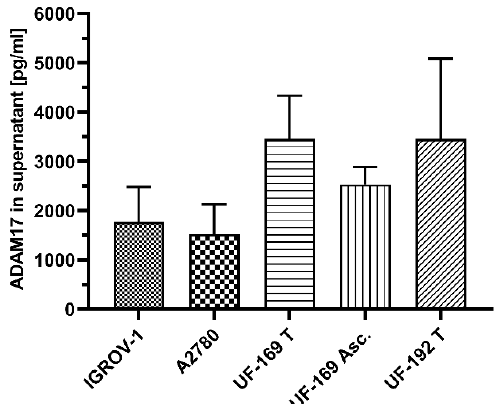
Figure 1. Detection of ADAM17 in CM of cultured cell lines IGROV-1, A2780 and patient-derived tumor cells isolated from tumor tissue and ascites Three independent biological experiments were carried out with two technical replicates each. No statistically significant correlation between the individual cell lines (ANOVA using Kruskal–Wallis test p = 0.35). Data presented as the mean + SEM. ADAM17 concentrations: IGROV-1: 1772 pg/mL, A2780: 1522 pg/mL, UF-169 T-tumor: 3456